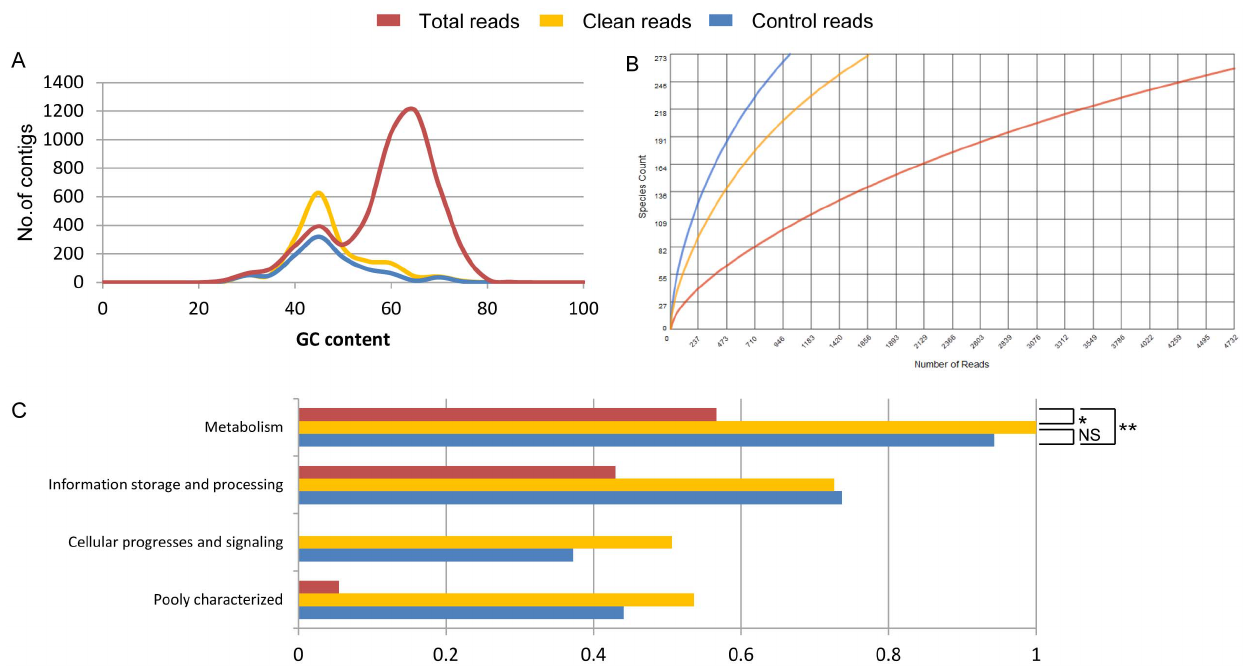
Figure 5. Comparison of the results from clean, total and control reads of simulated metagenomic data. (A) GC distribution pattern. (B) Rarefaction curve that could discriminate the richness of different bacterial species, Y-axies: species count, X-axis: the number of reads. (C) Functional categories based on COG database. Abundance of each category between the three datasets was compared pair-wise (* p , 0.05; ** p , 0.01; NS: not significant).